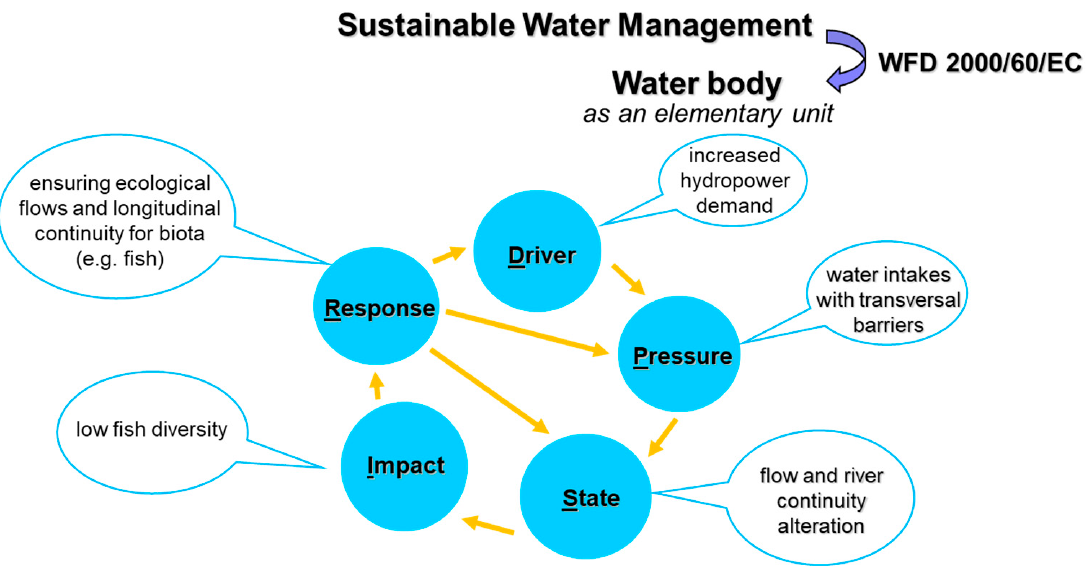
Figure 1. An illustration of the drivers–pressures–state–impacts–responses (DPSIR) analytical framework using as example hydrotechnical works.